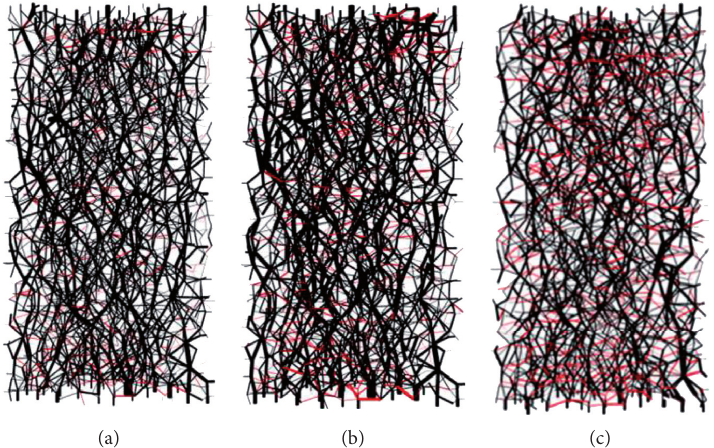
� 60kPa and f � of 1 Hz. (a) w � 6 . 9%. 0